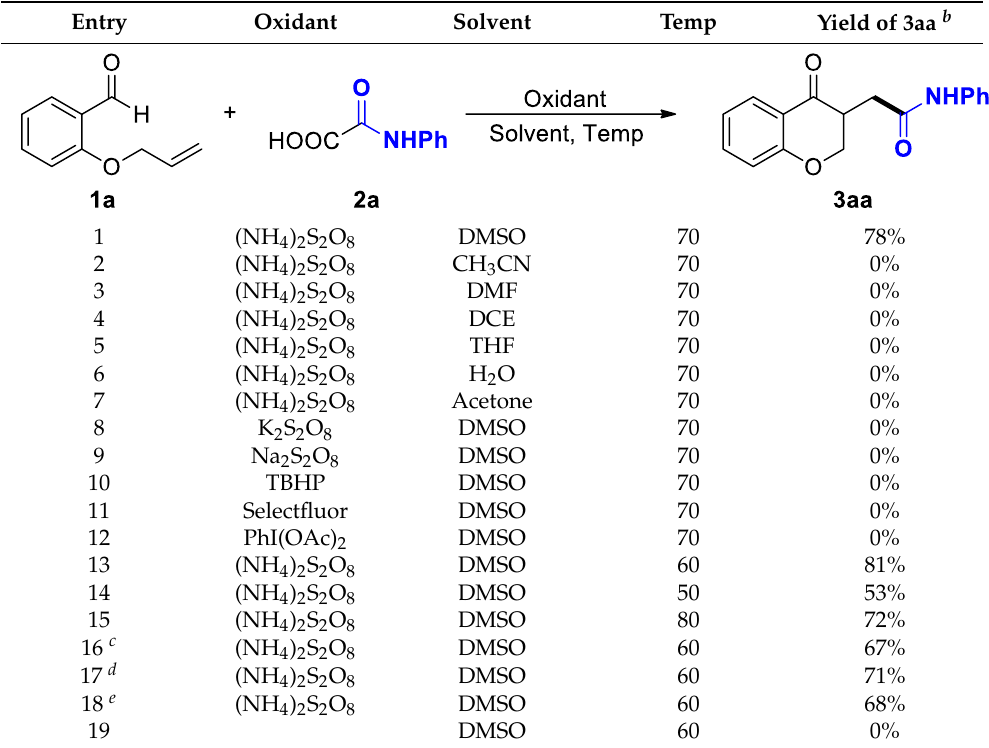
Table 1. Optimization of reaction conditions a .